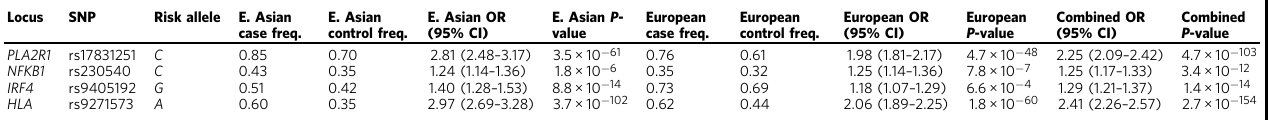
Table 2 Effect estimates for top GWAS SNPs by ethnicity and combined across all cohorts. Locus SNP Risk allele E. Asian case